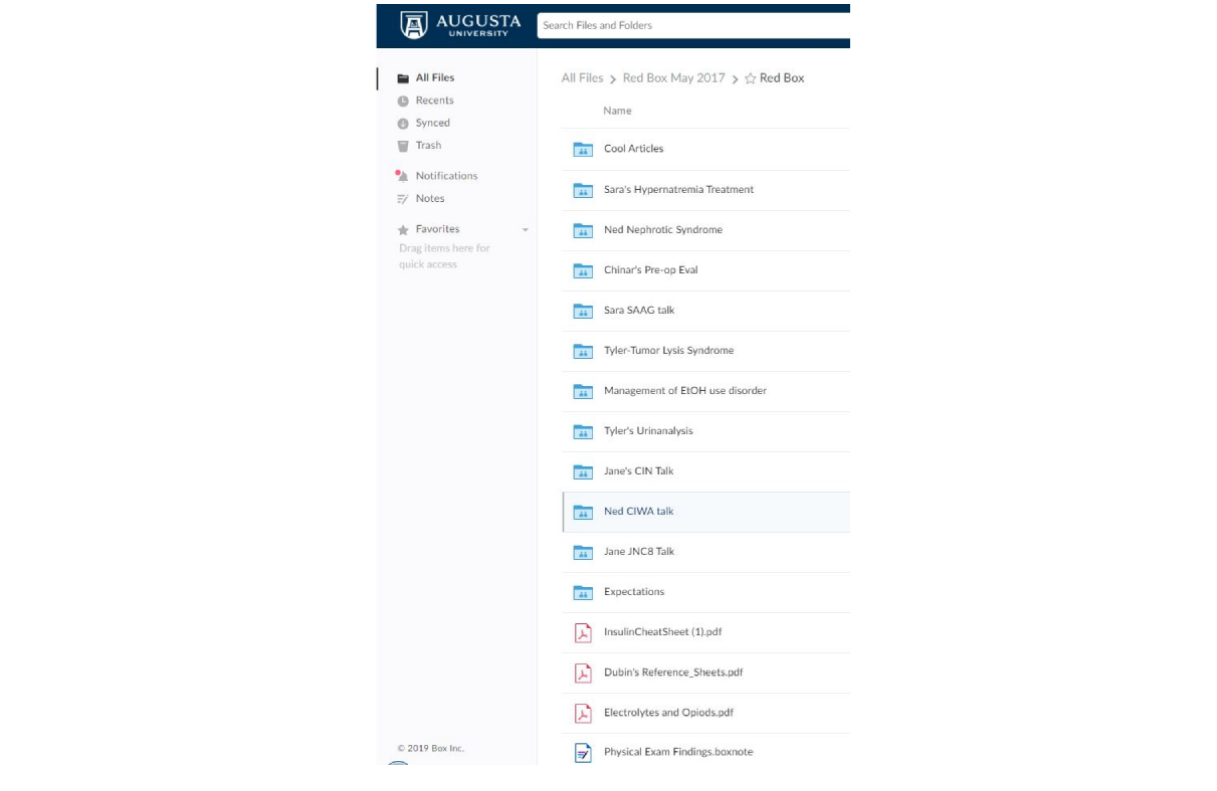
Figure 4. Screenshot that shows an example of what the Box folder looks like at the end of a rotation.